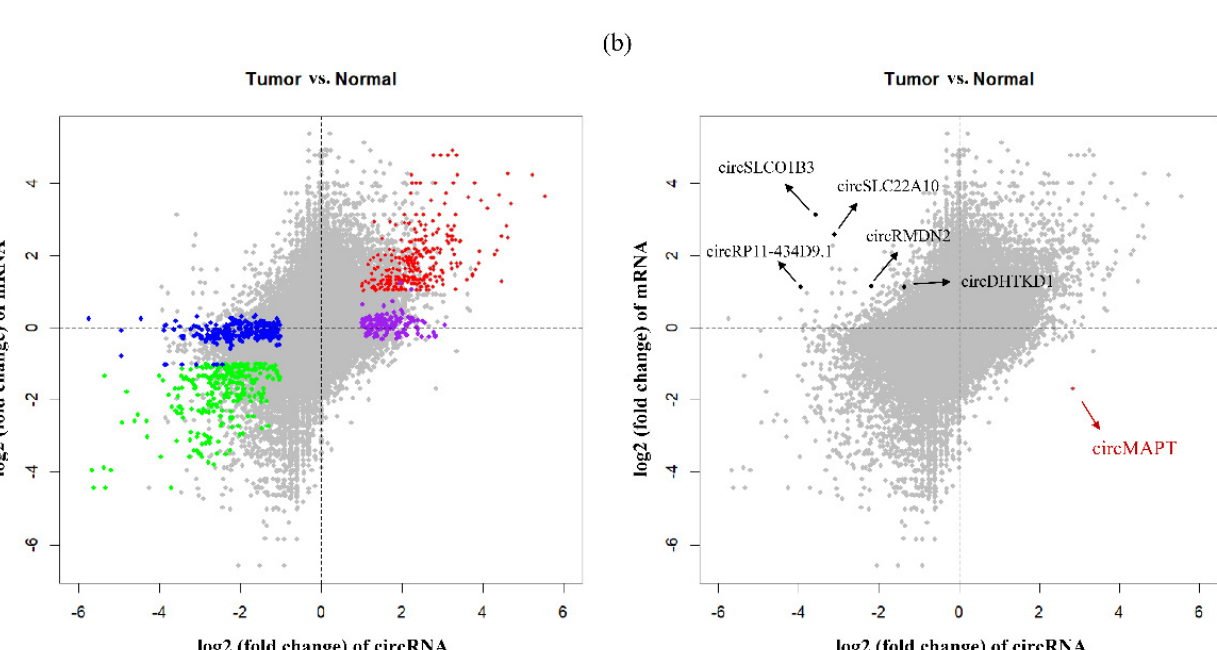
9 of 20 Figure 3. Performance of six machine learning methods (DT, GB, KNN, LR, RF, and SVM, as shown in Figure 3a–f) on differentially expressed circRNAs for predicting hepatocellular carci- noma. DT: Decision Tree. GB: Gradient Boosting. KNN: K-Nearest Neighbor. LR: Logistic Regres- sion. RF: Random Forest. SVM: Support Vector Machine. 3.2. The Differential Expression Pattern of circRNAs and Genes in HCC Genome-scale gene expression of primary tumor and matched adjacent normal sam- ples for 20 HCC patients were examined by the tools in Figure 1a. Principal component analysis of the genes revealed a significant differentiation between the tumor and normal samples (Figure 2c). DESeq2 was used to identify the DE genes based on read counts. By statistical anal- ysis, we drew volcano plots for the genes in HCC paired samples (|log2 (fold change)| > 1, adjusted p -value < 0.05) (Figure 2f). In total, 12,097 differentially expressed genes were identified. Among them, 7087 genes (58.58%) were upregulated, and 5010 genes (41.42%) were downregulated in tumor samples. As shown in Figure 2i, all HCC samples were clustered together by gene expression data. After combining the DE circRNAs’ expression in Figure 2g, the results suggested that HCC samples had distinct transcriptomic changes at both the gene and circRNA molecular levels when compared to control samples. Because circRNAs were derived from their precursor mRNA (pre-mRNA) splicing process, we examined the expression level of DE circRNA’s parental genes and compared the expression pattern of circRNAs and their parental genes in HCC. Interestingly, despite